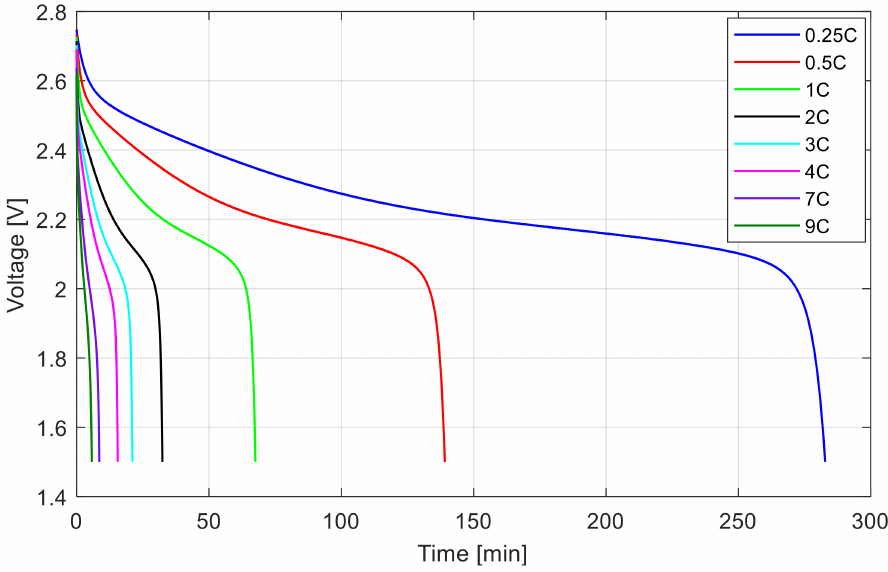
Figure 3. Voltage changes with discharging